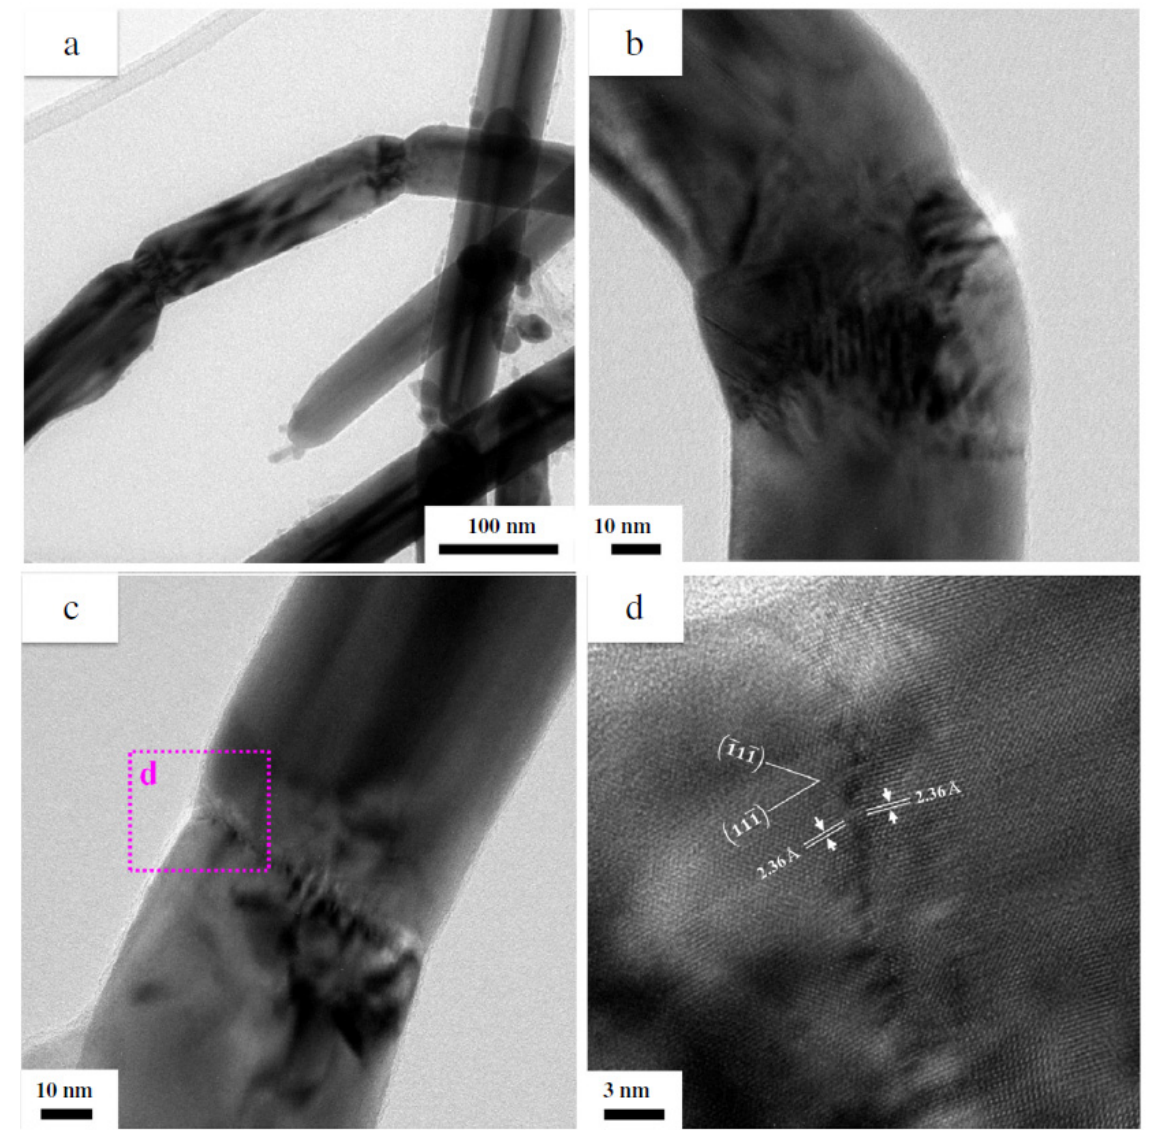
Figure 13. ( a – c ) TEM images of silver nanowires with sub-grain boundaries due to buckling, and ( d ) high-magnification image taken at the magenta square in ( c ). Reproduced with permission from ref. [43]. Copyright 2016, Elsevier.